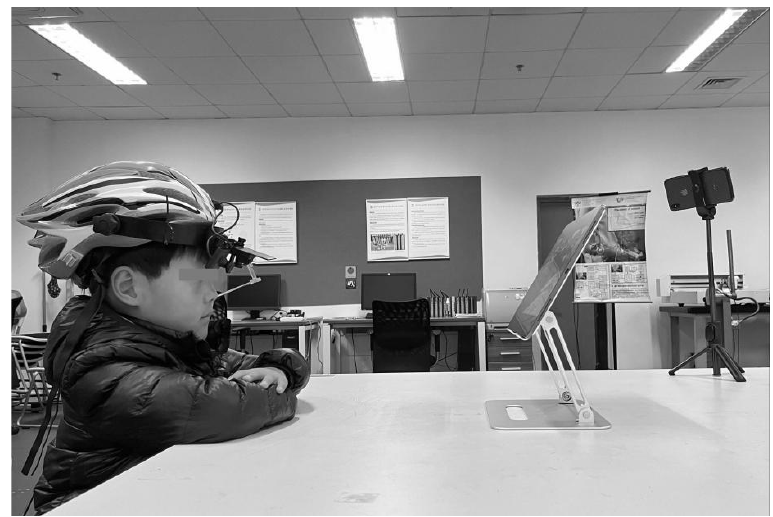
Figure 2. SMI headset eye tracker usage scenarios.